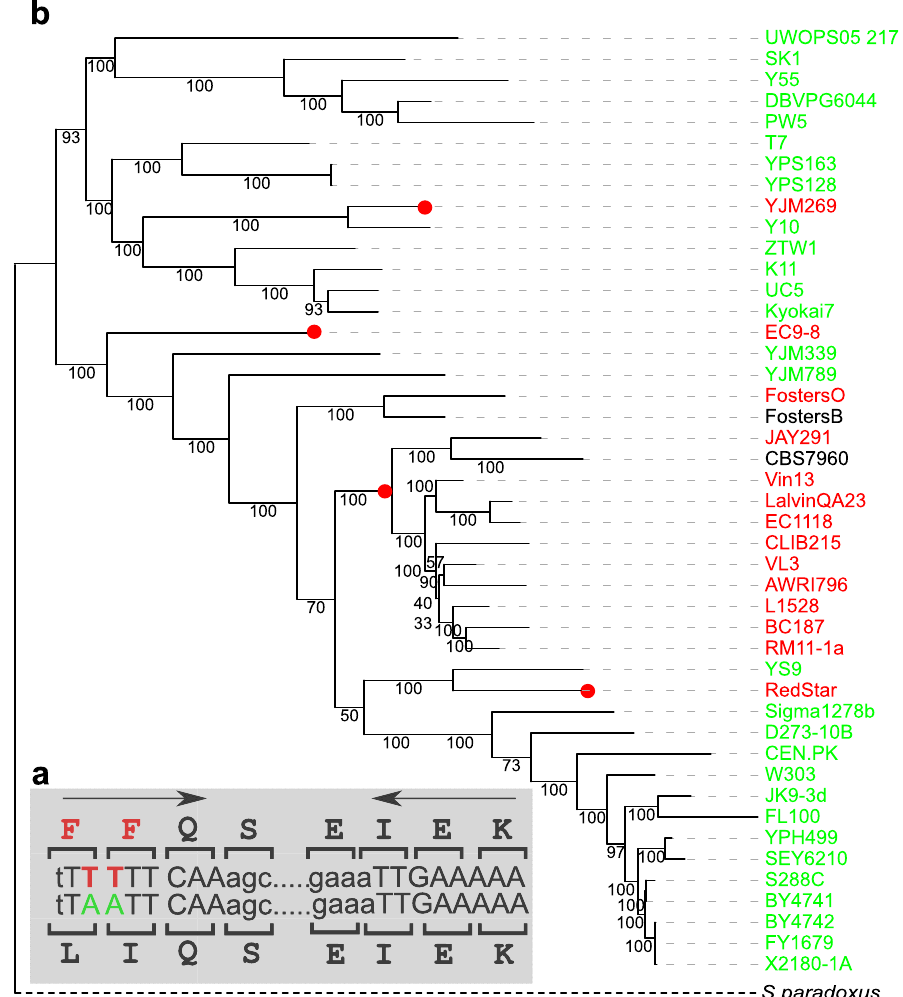
Figure 2. Template switching events forming an IR in the gene MSH4 . ( a ) The homogenous IR has an arm length of 8 bp (upper sequence). The IR homogenesis was formed by an AA → TT MNM and resulted in two amino acid changes, i.e., L394F, I395F. The spacer is not shown. ( b ) Placing of template switching events on the tree. Fourteen strains with perfect IR and the TT form are shown in red, strains with the AA form are shown in green and other forms are shown in black. Template switching occurred on three terminal branches in S. cerevisiae lineage (red circles): on the branches leading to YJM269, RedStar, and EC9-8. While not